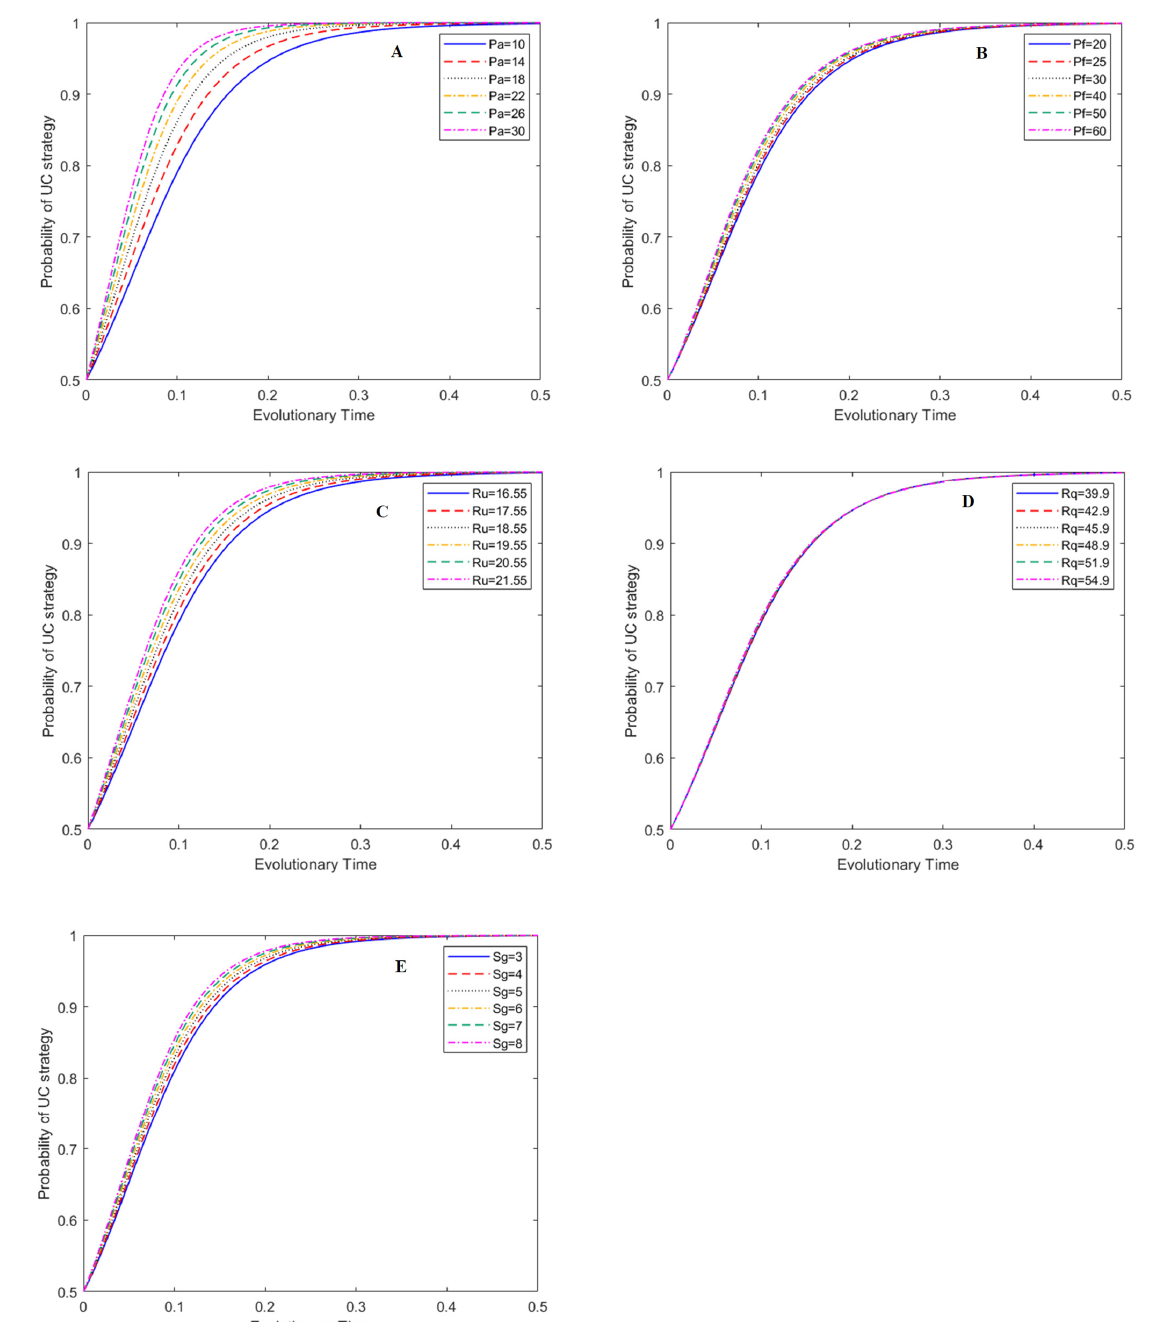
Figure 4. Effects of main parameters on the evolution of UC strategy under (1, 1, 0), subfigures A–E represent the effects of P a , P f , R u , R q , and S g on the evolution of UC strategies, respectively.